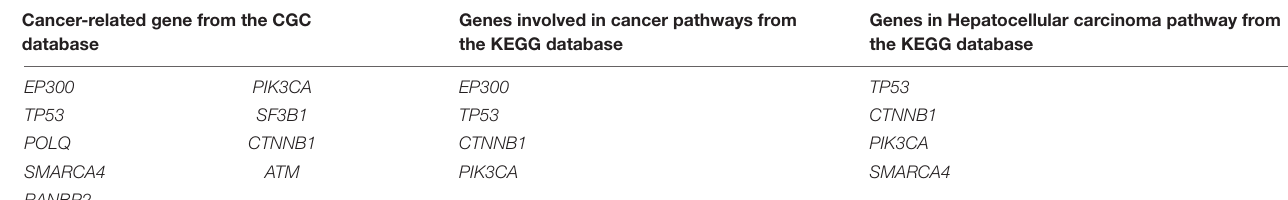
FIGURE 3 | Validation of identified disease module. (A) In total, 723 known cancer genes were obtained from the CGC database and nine of them are identified as disease-related genes. (B) In total, 168 hepatocellular carcinoma-associated genes were obtained from the KEGG database and four of them are identified as disease-related genes. TABLE 1 | Common genes between predicted disease-related genes and known cancer